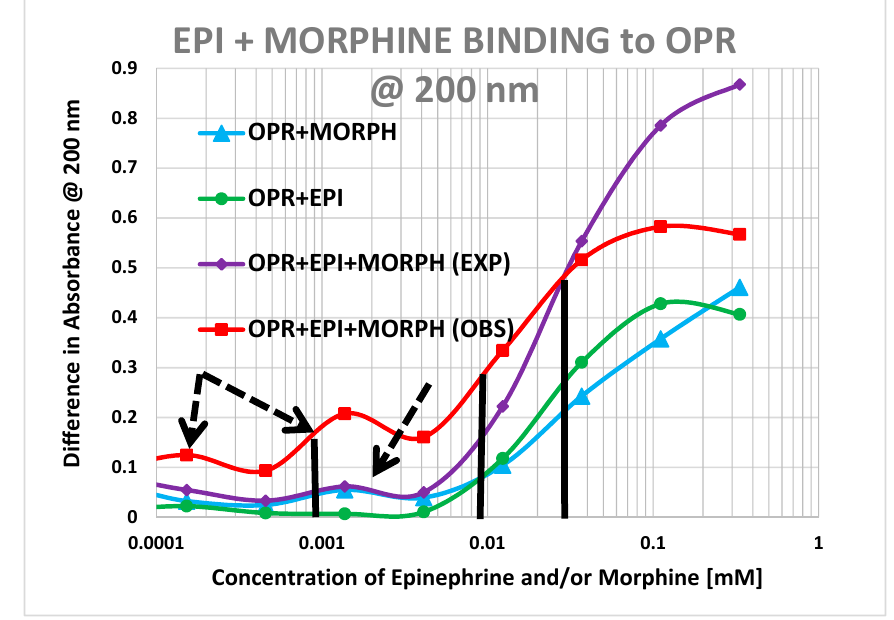
Figure 20. Mu opioid receptor (OPR) binding curves with morphine, epinephrine (EPI) and their combination (MORPH + EPI) at 200 nm. There is a half-log unit shift to the left (black vertical lines) in the observed binding as compared with the predicted binding and the possibility of high affinity binding of morphine to the muOPR appears to be present and is enhanced in the presence of EPI (dashed